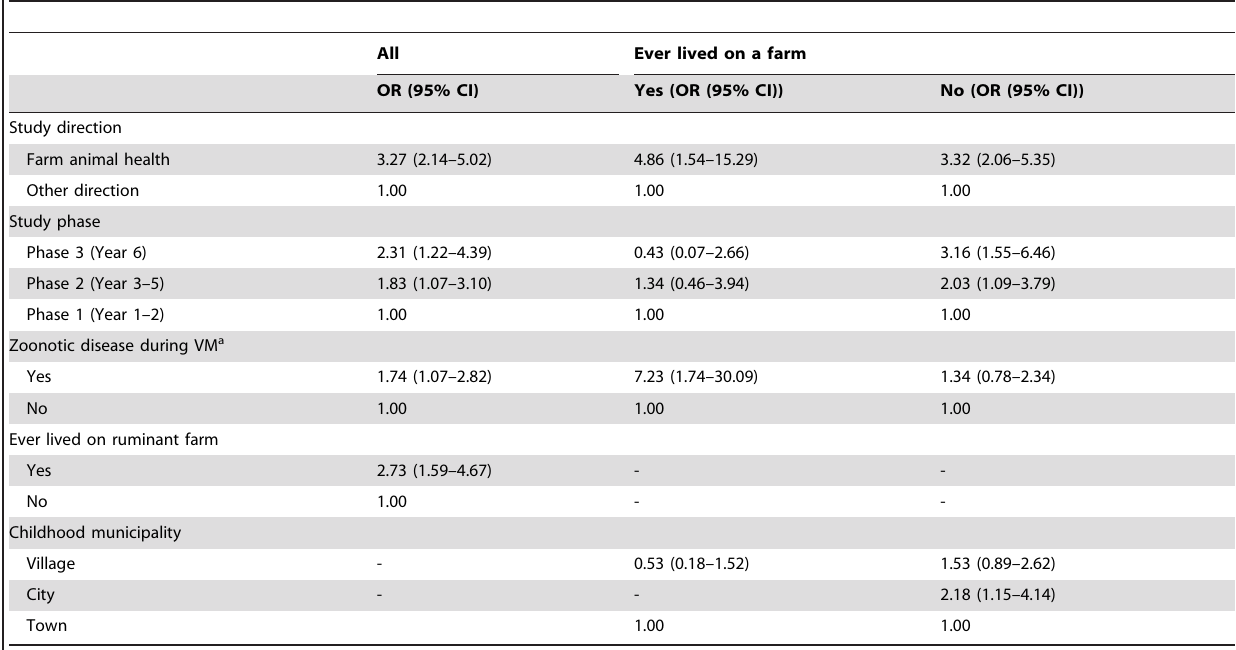
Table 5. Factors associated with Coxiella burnetii seropositivity obtained by multivariate analysis for all students and stratified by ever lived on a